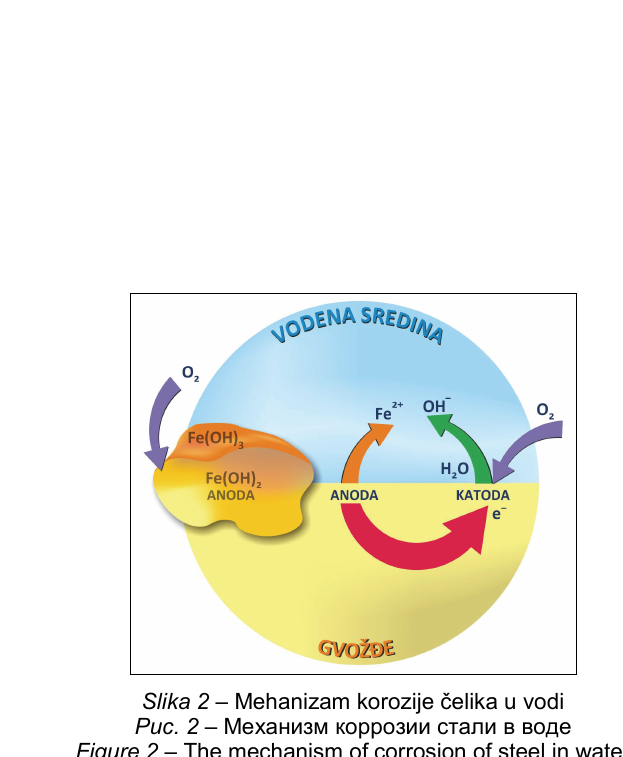
Figure 2 – The mechanism of corrosion of steel in